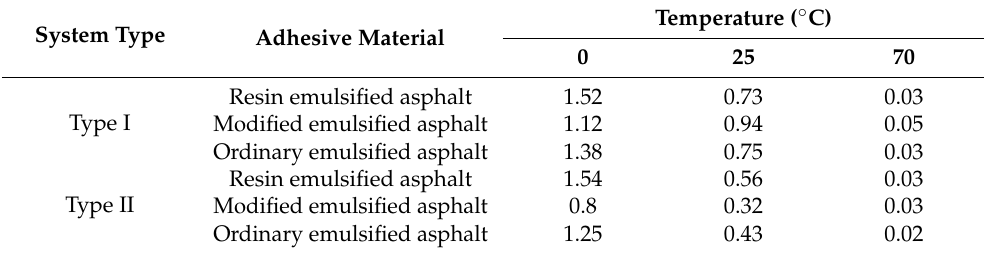
Table 3. Interface bond strength, (MPa).